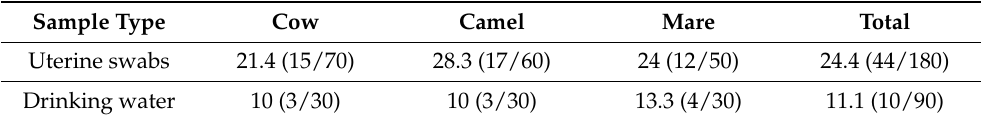
Table 1. Percentage (N/N) of P. aeruginosa isolates recovered from the uterine swabs of different animal species and the drinking